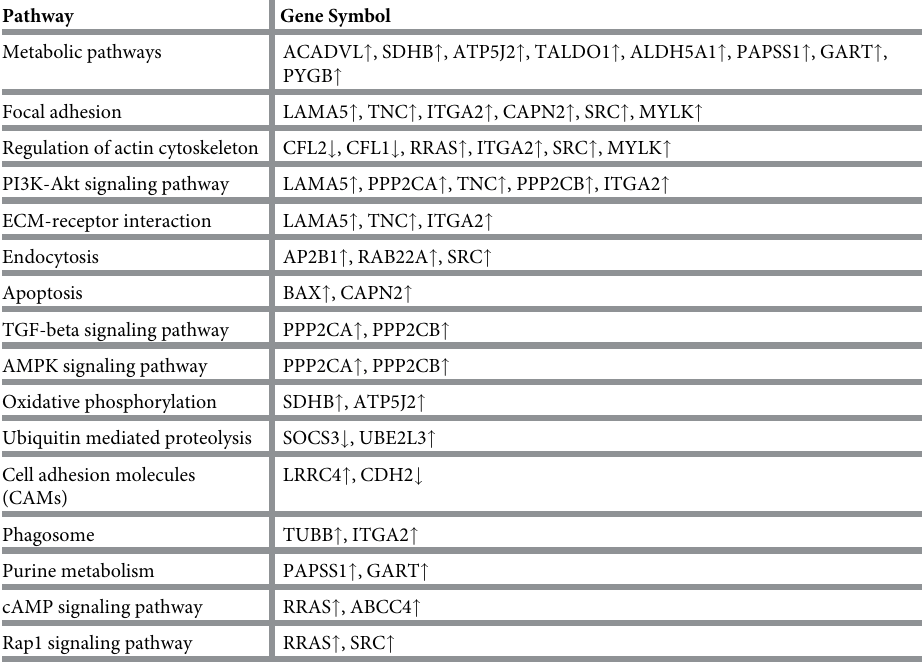
Table 2. Pathway analysis of fibroblast-sEVs involved in SUI compared with